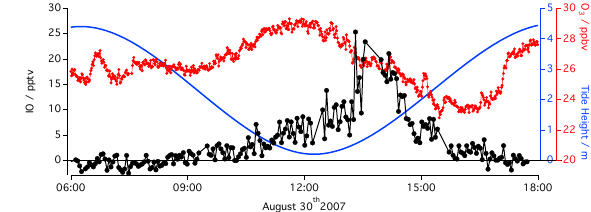
Fig. 10. Time series of IO and O 3 (60s) and tidal height (m) for 30 August,